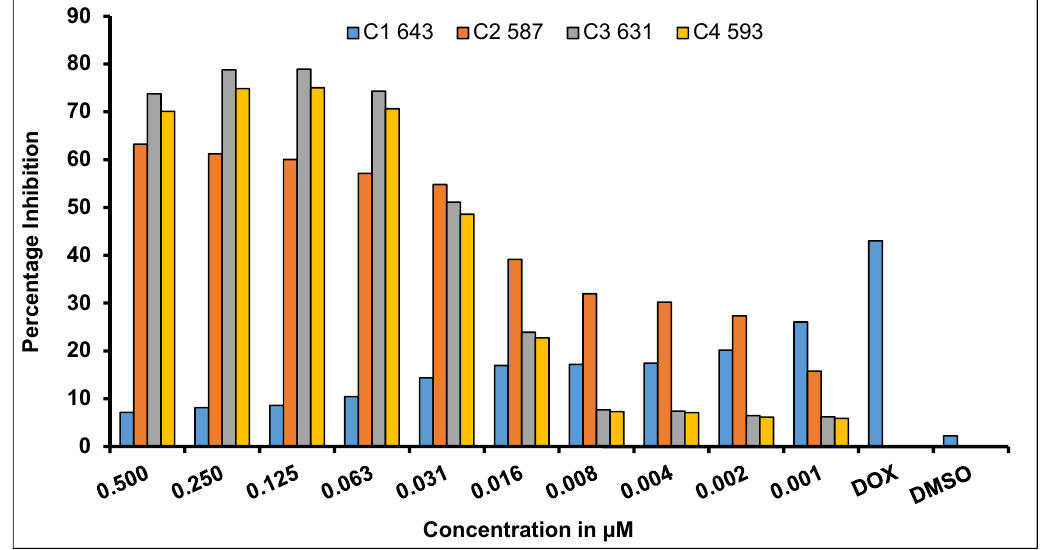
Figure 2. Sulforhodamine B (SRB) colorimetric assay in HeLa cell line (cervical cancer) culture to analyze percentage inhibition for all complexes. Doxorubicin was used as a positive control, while DMSO was used as a vehicle control. Table 2. Concentrations of the complexes used in SRB assay with the values converted to µM. M W , molecular weight.